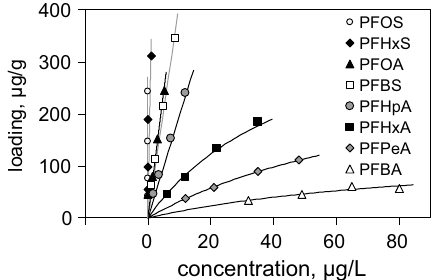
Fig. 2 Isotherms of the sorption of different PFAS onto IEX K6362 (matrix: tap